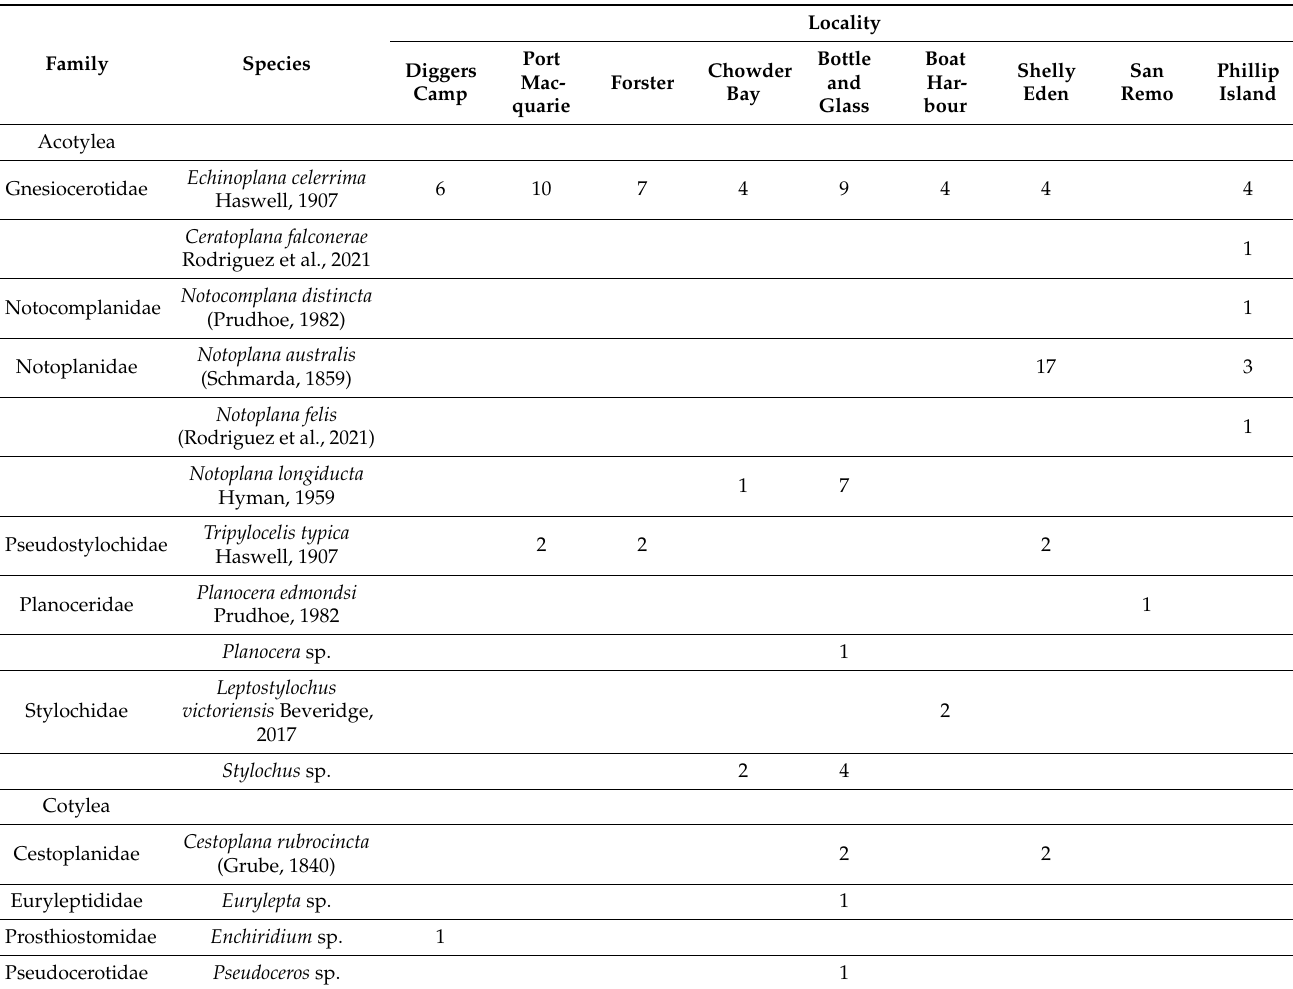
Table 3. Species and number of individuals found in intertidal boulder beaches in southeastern